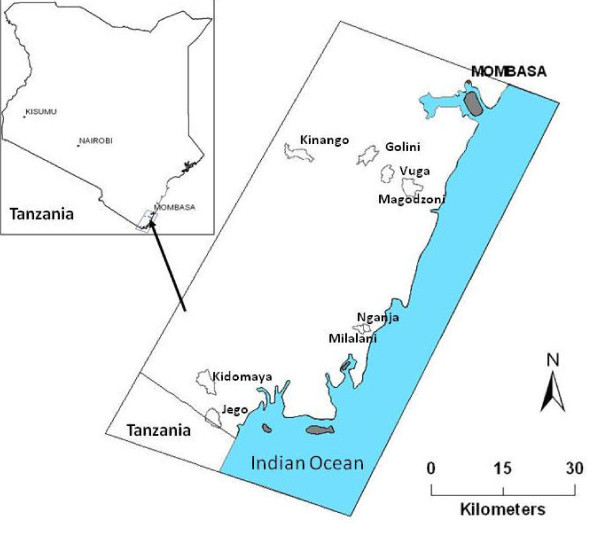
Map of the study area, Inset: map of Kenya showing the location of study area.